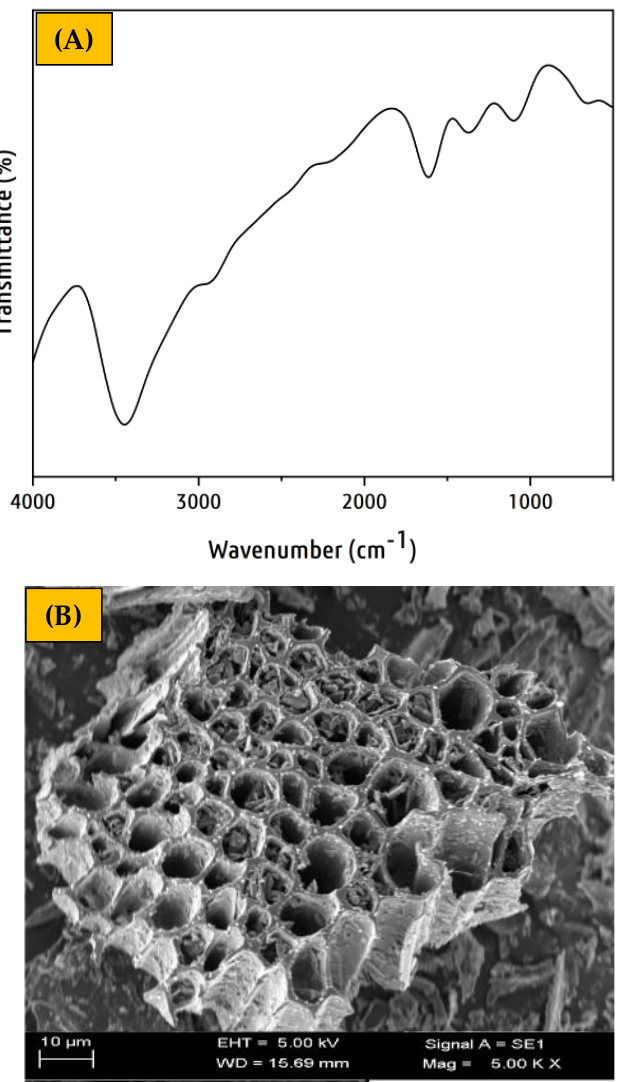
Figure 2. FTIR analysis ( A , B ) SEM image of Burmese grape-seed-derived biochar.